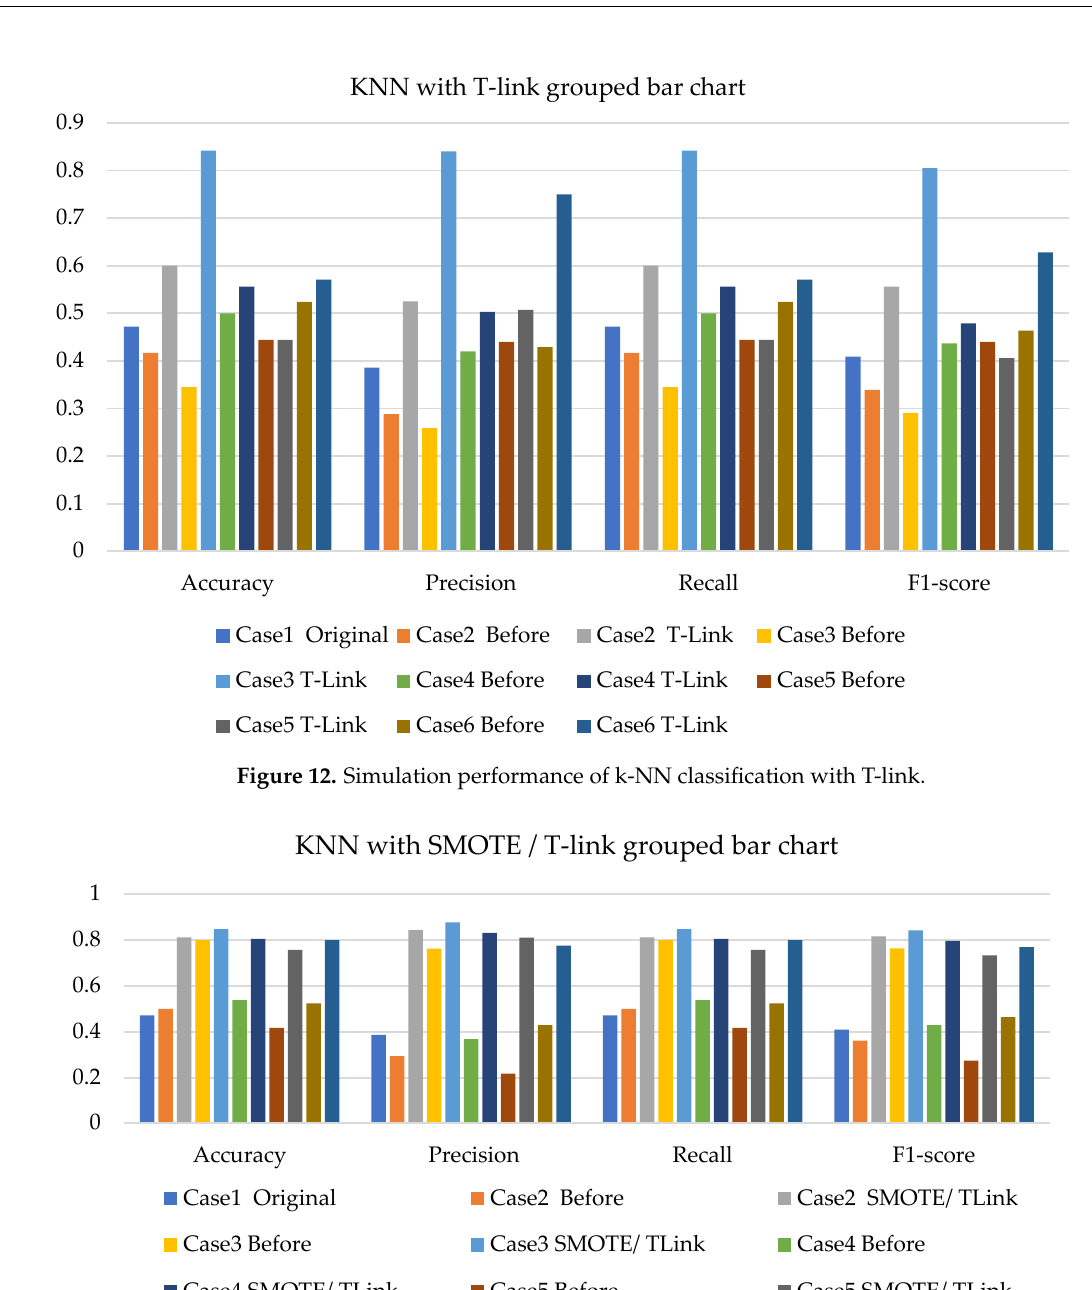
Figure 11. Simulation performance of k-NN classification with SMOTE.